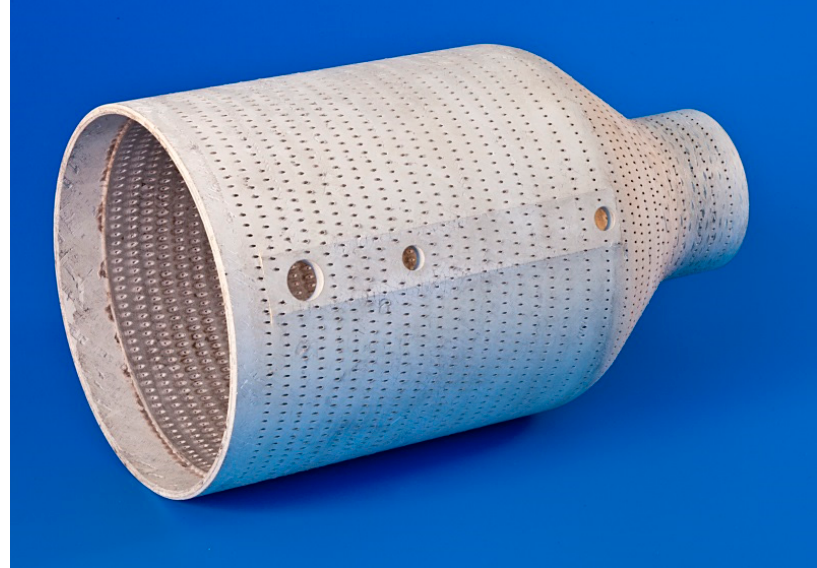
Figure 1. CMC-Liner with an outer diameter of 135 mm and 3540 laser drilled effusion holes. The thickness of the yttria coating on the inner surface was 1.0 mm.